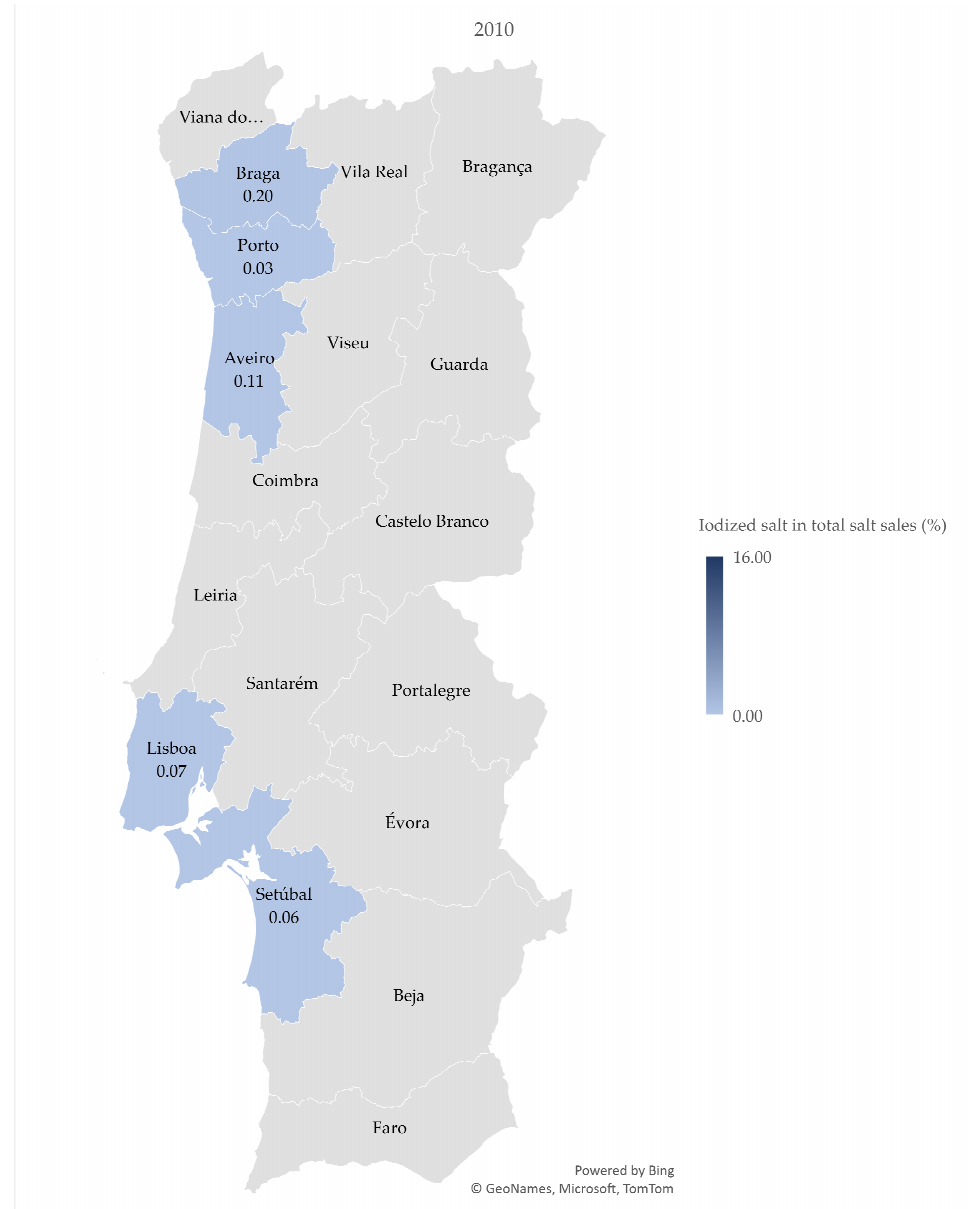
Figure 1. Percentage of iodized salt in total salt sales by district in 2010.